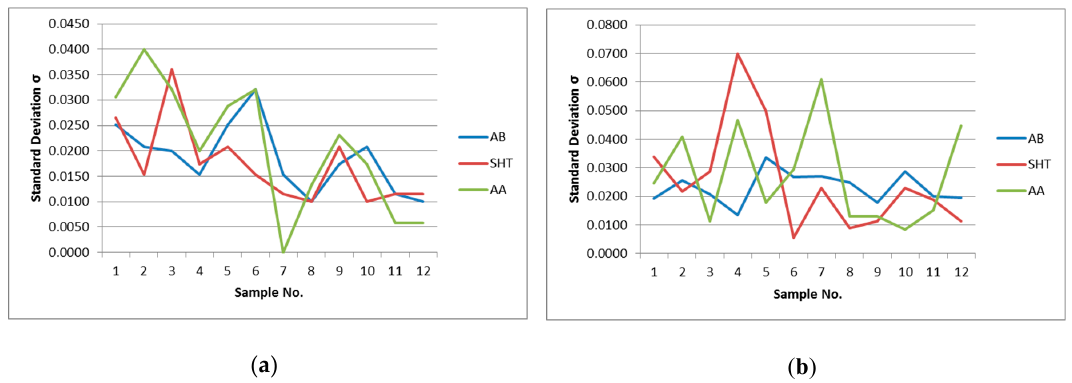
Figure 10. Standard Deviation σ in sample ( a ) length and ( b ) height comparison in AB, SHT, and AA conditions.